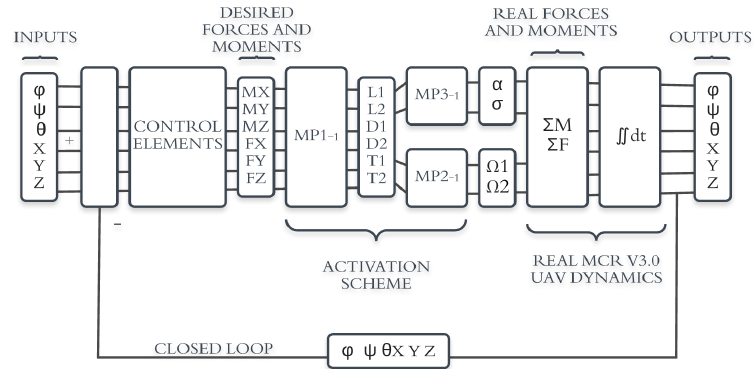
Figure 17. Control scheme proposed for the MCR UAV v3.0.